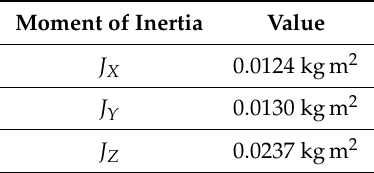
Table 3. Computed moment of inertia of the